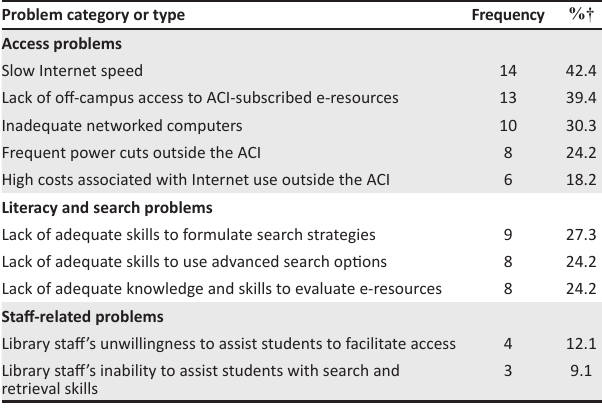
TABLE 3: Problems encountered in accessing e-resources used by postgraduate